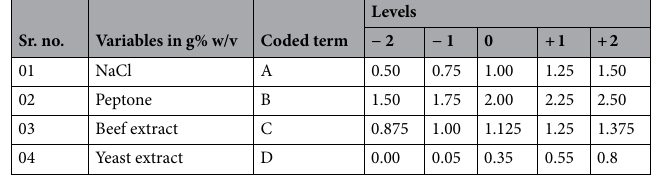
Table 1. Variables and their levels for